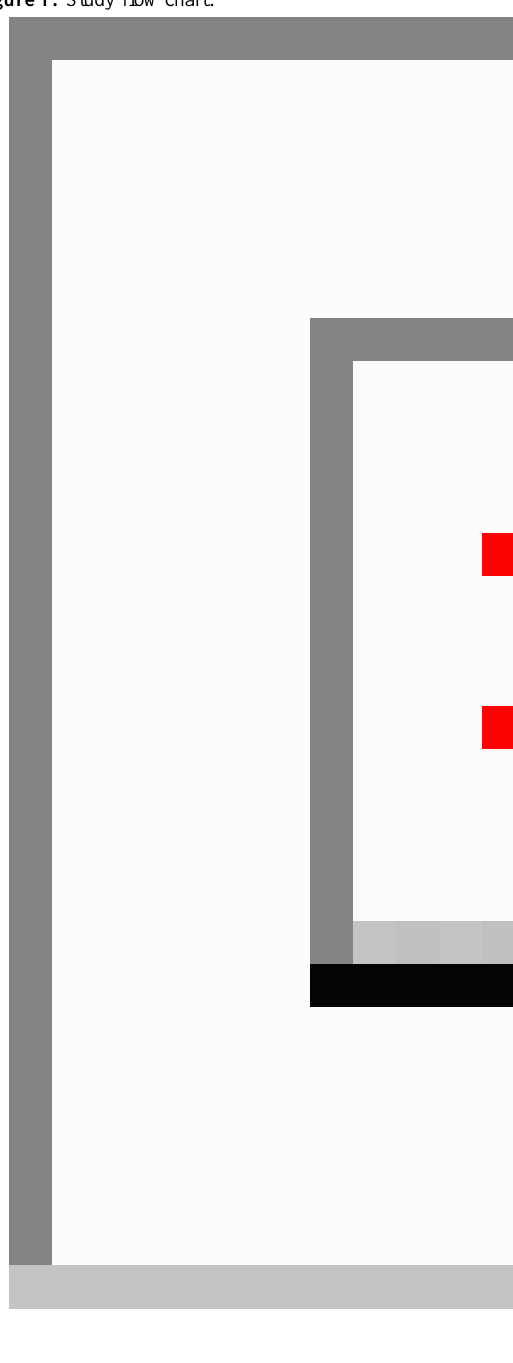
Figure 1. Study flow